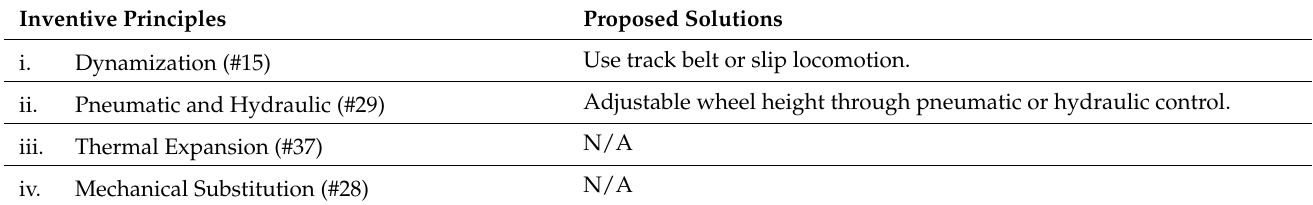
Table 5. Proposed solutions based on principles from parameters #35 and #36 within the contradic- tion